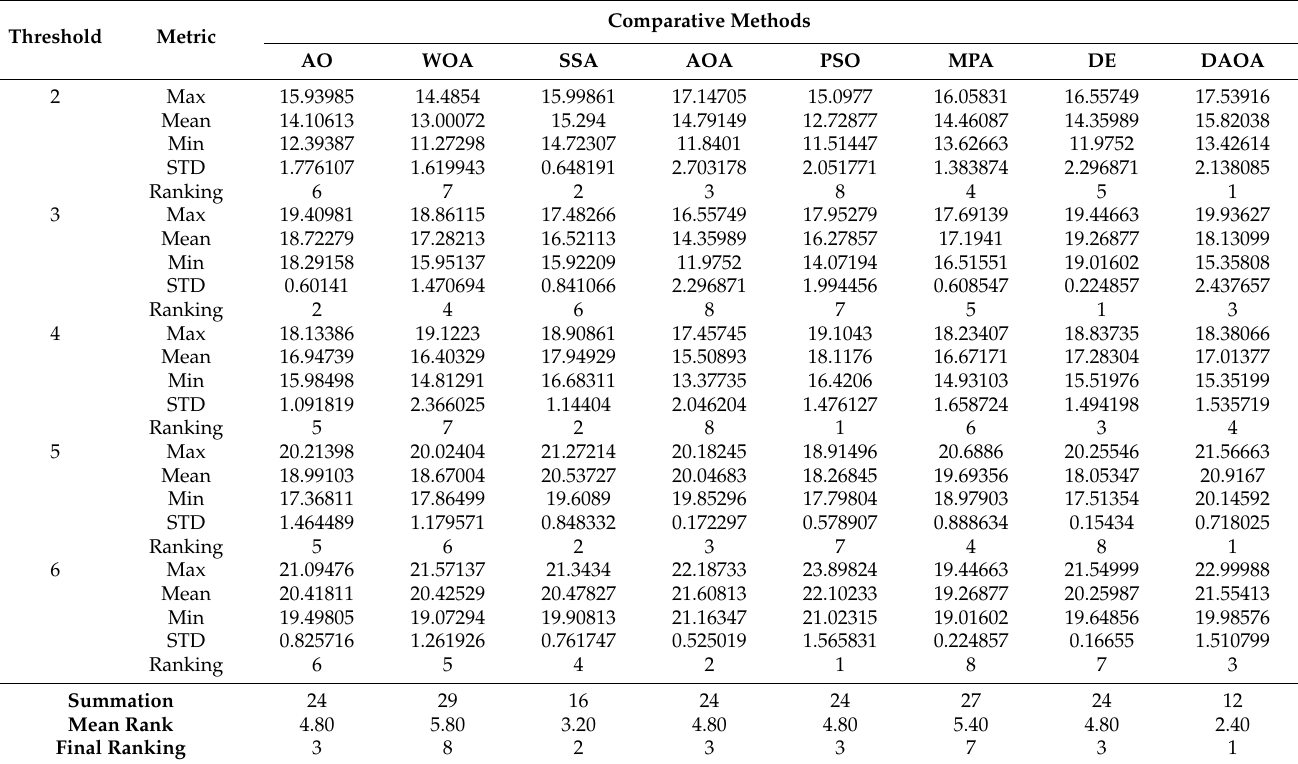
Table 10. The PSNR results of the test case 5.